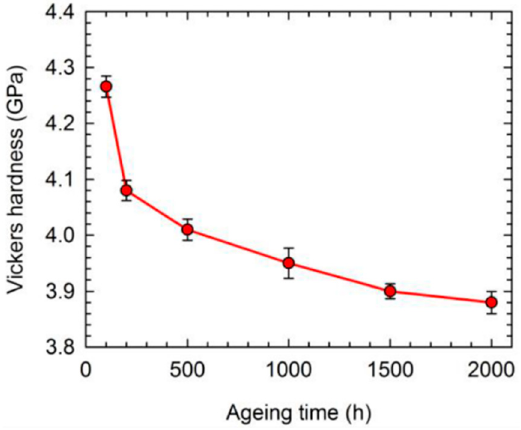
Figure 16. ( a ) Typical strain–stress curves at 950 °C of exposed samples for different time at 950 °C and ( b ) effect of thermal exposure time on 0.2% offset yield strength (YS), ultimate tensile strength (UTS) and plastic elongation to fracture of CMSX-4 alloy [61].